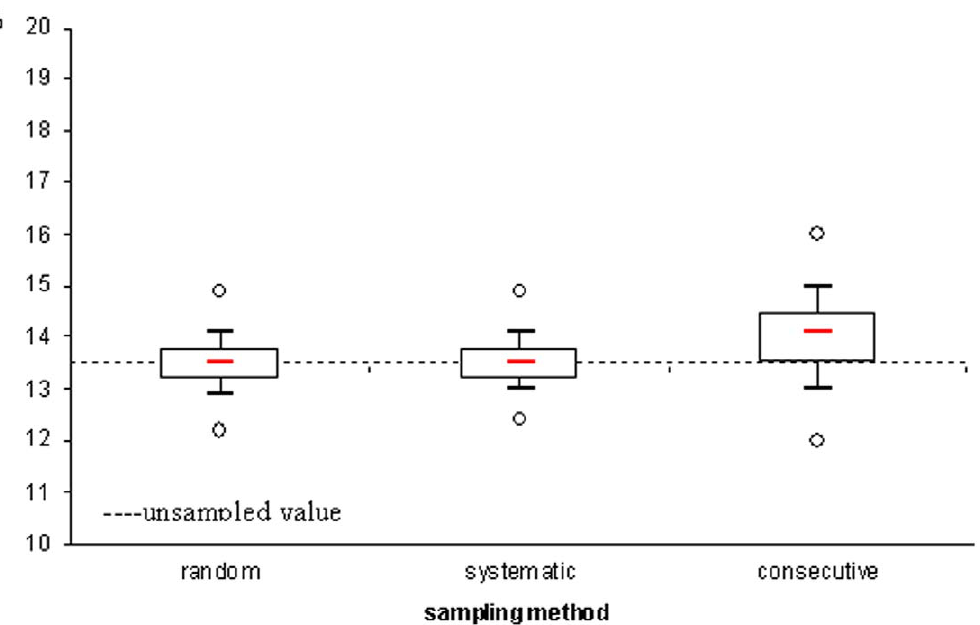
Figure 2. Proportion of patients lost to follow-up at 12 months: comparison of estimates according to the sampling technique (median, inter-quartile range, 10–90% deciles and minimum maximum) with the unsampled value (dotted line).